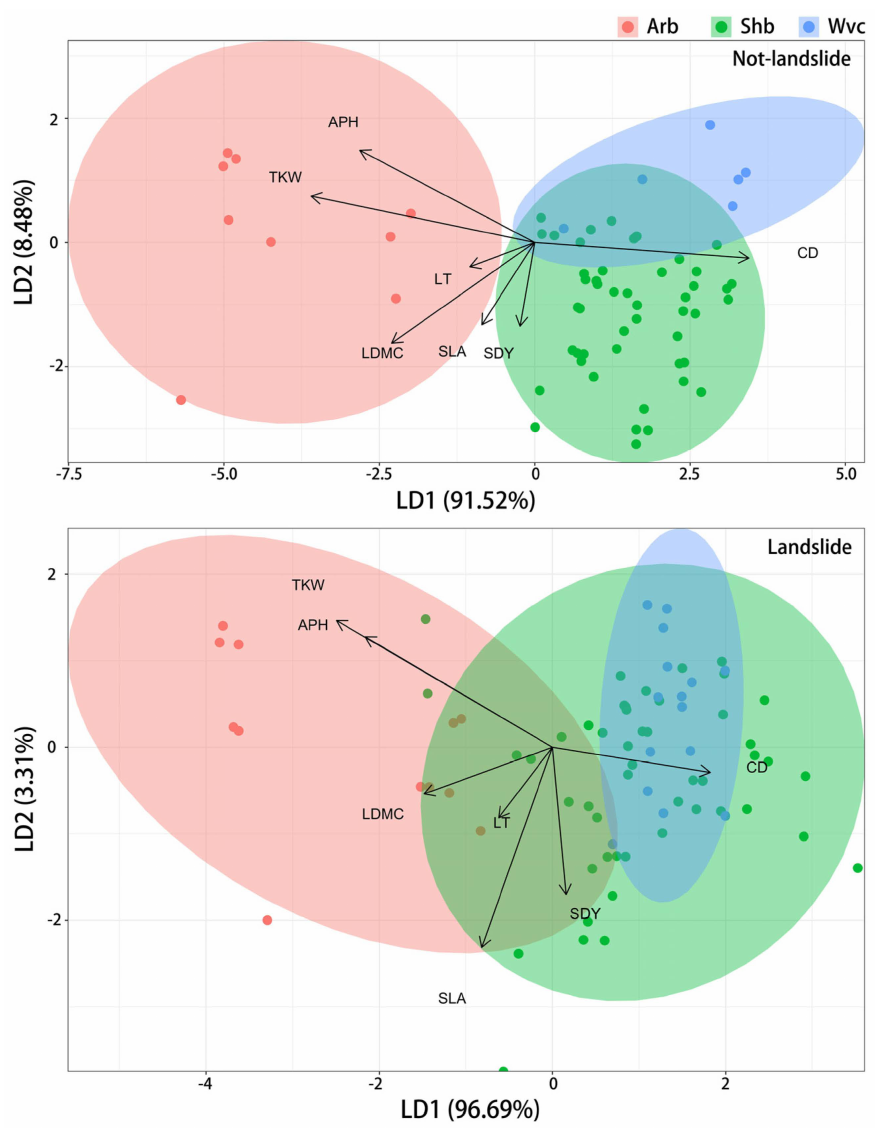
Figure 5. Linear discriminant analysis of different WFTs in landslides and nonlandslides. Abbrevia- tions are as follows: SLA, specific leaf area; LDMC, leaf dry matter content; SDY, stem density; LT, leaf thickness; APH, average plant height; CD, crown diameter; TKW, thousand kernel weight. The ellipse represents the 95% confidence